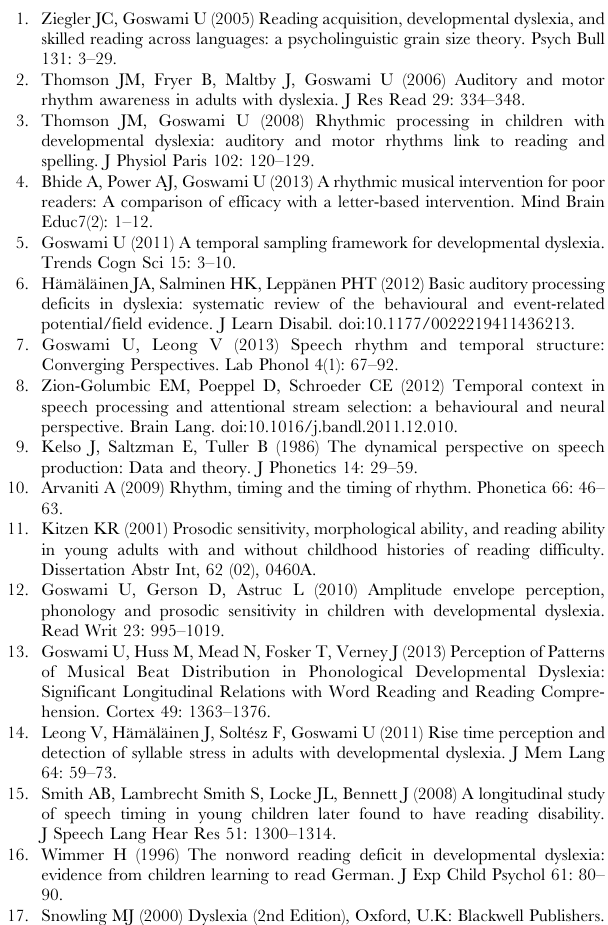
Figure S1 Impulse response of digital filters. Black line: simulated data of an 1600 ms long signal (sampling rate